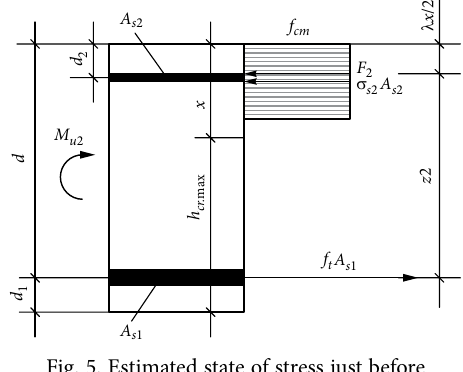
Fig. 5. Estimated state of stress just before construction